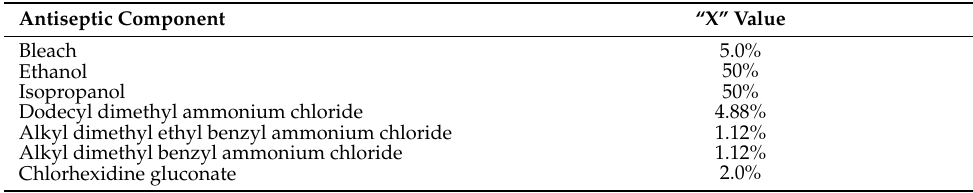
Table 6. Starting concentrations for MIC